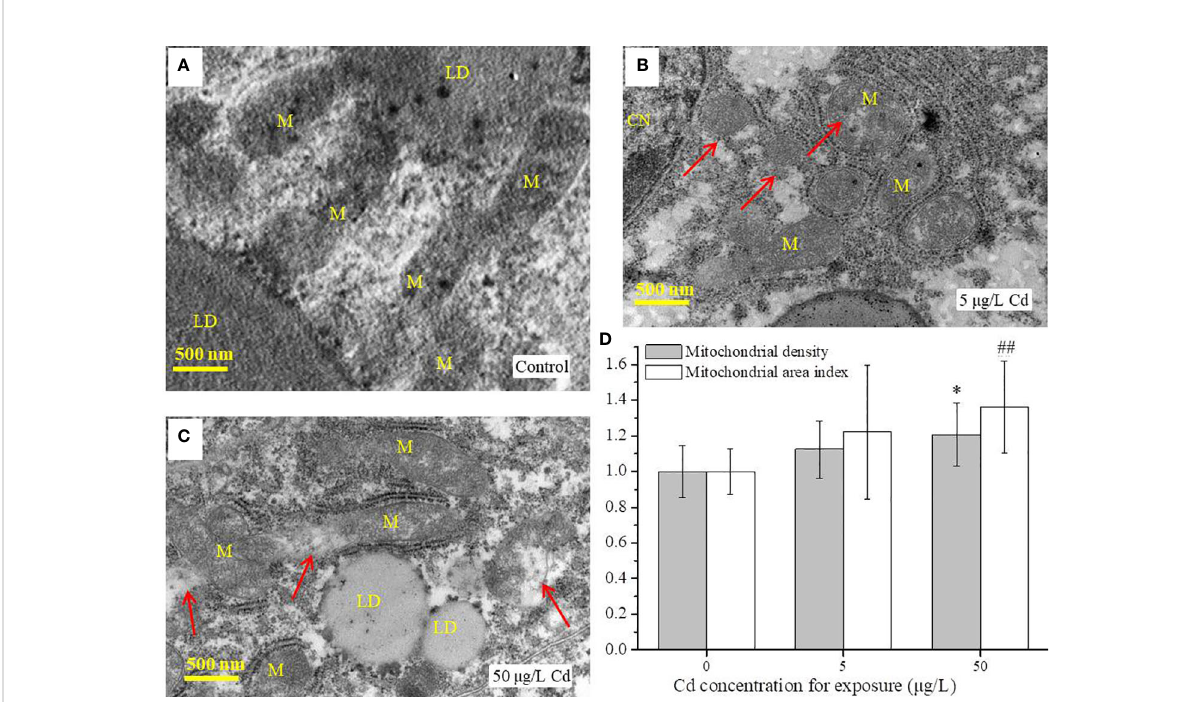
FIGURE 2 TEM analysis of liver tissues ( n = 3) from control and Cd treatments after exposure for 14 days. (A – C) images of mitochondria in fl ounder livers; (D) the mitochondrial area index and mitochondrial density of liver samples ( n = 3 × 3) from each group. Scale = 500 nm. Red arrows indicate the damaged mitochondria. Values are normalized by setting the control value as 1. ## represents P < 0.01, and * represents P < 0.05. M, mitochondria; LD, lipid droplet; CN, cell